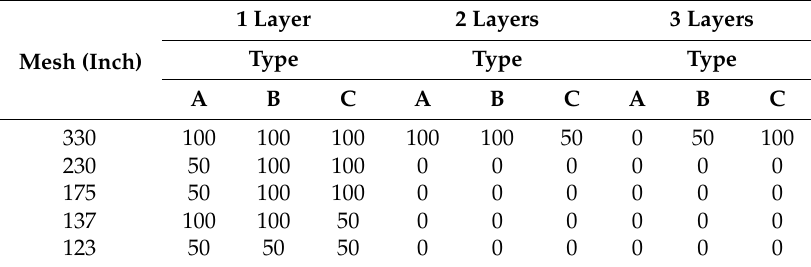
Table 2. Failures rate (%) for OLD when 1–3 layers of dielectric ink are used.